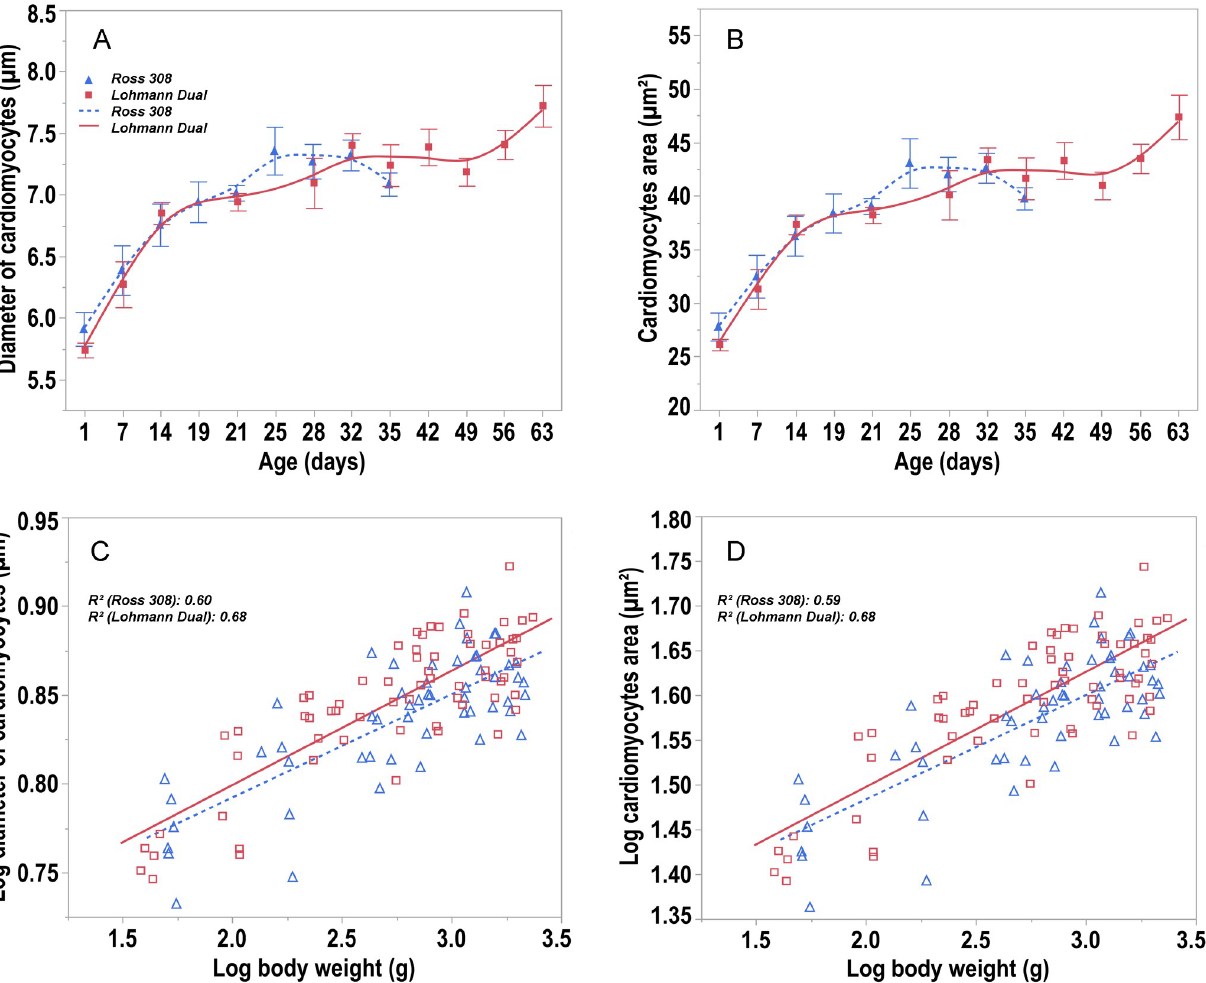
Fig 7. Trendlines of the changes in diameter and cross sectional area of cardiomyocytes versus day post hatching. (A) diameter of cardiomyocytes and (B) cross sectional area of cardiomyocytes versus day post hatching for Ross and LD chicken lines. Bars refer to mean ± standard error of the mean of the chicken samples at each time interval. (C) allometric plot: log transformed diameter of cardiomyocytes and (D) cross sectional area of cardiomyocytes versus log of body weight post hatching for Ross and LD chicken lines. Symbols represent each individual value for each chicken line.